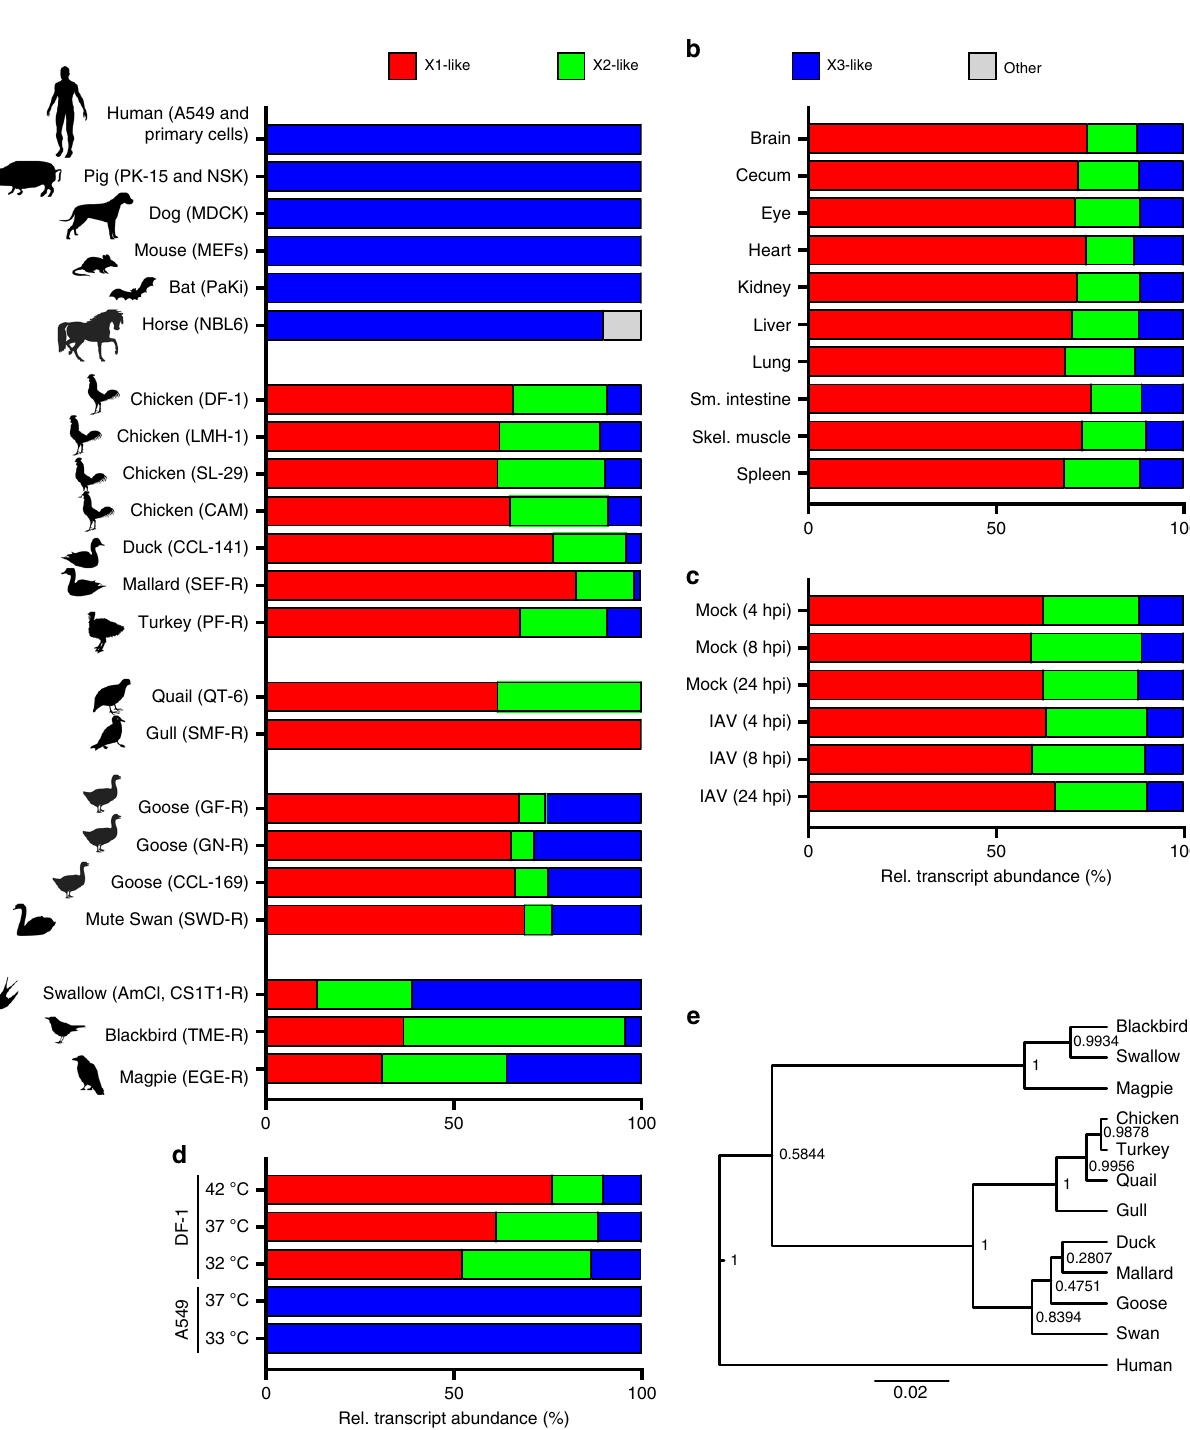
Fig. 3 ANP32A splicing ratios vary across species, and can be affected by temperature. a Relative abundance of ANP32A X1-, X2-, and X3-like isoform transcripts in cells from various mammalian and avian species, as determined experimentally by NGS quanti fi cation of cDNA-derived amplicons. b – d Relative abundance of ANP32A X1-, X2- and X3-like isoforms in: b different tissues derived from a healthy adult chicken; c uninfected and infected chicken DF-1 cells (WSN, MOI = 1 PFU/cell); d chicken DF-1 and human A549 cells cultured for at least 72 h at the indicated temperatures. In all panels, data are representative of at least three replicate samples. See also Supplementary Tables 1 and 2. e Phylogenetic analysis of the determined ANP32A_X1 sequences from each species to infer evolutionary relationships. The plot shows the maximum clade credibility tree with posterior con fi dence of splitting events at the nodes of the tree. The scale bar represents the number of nucleotide substitutions per